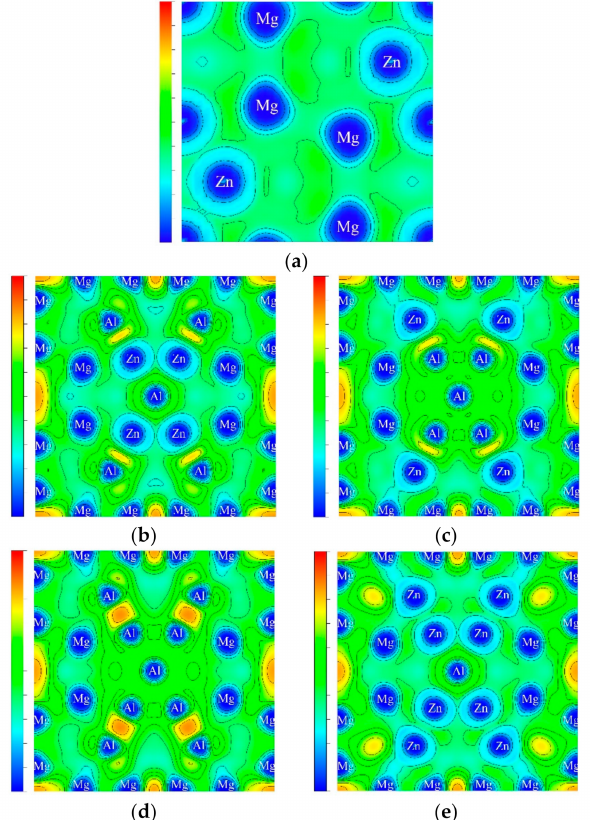
Figure 3. ELF contours: ( a ) (1120) plane of MgZn 2 ; ( b – e ) (002) plane of ( b ) Al 26 Zn 72 Mg 64 –C; ( c ) Al 26 Zn 72 Mg 64 –B; ( d ) Al 50 Zn 48 Mg 64 –F; ( e ) Al 50 Zn 48 Mg 64